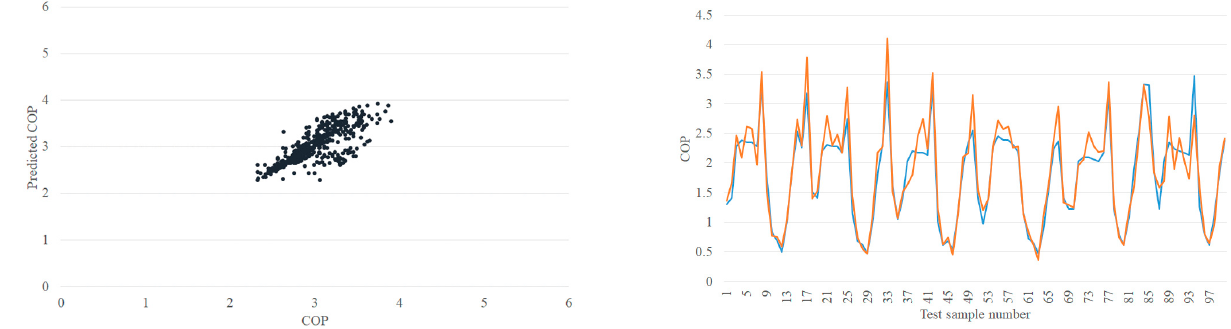
Figure 8. Comparison of predicted and measured performance using KNN model.